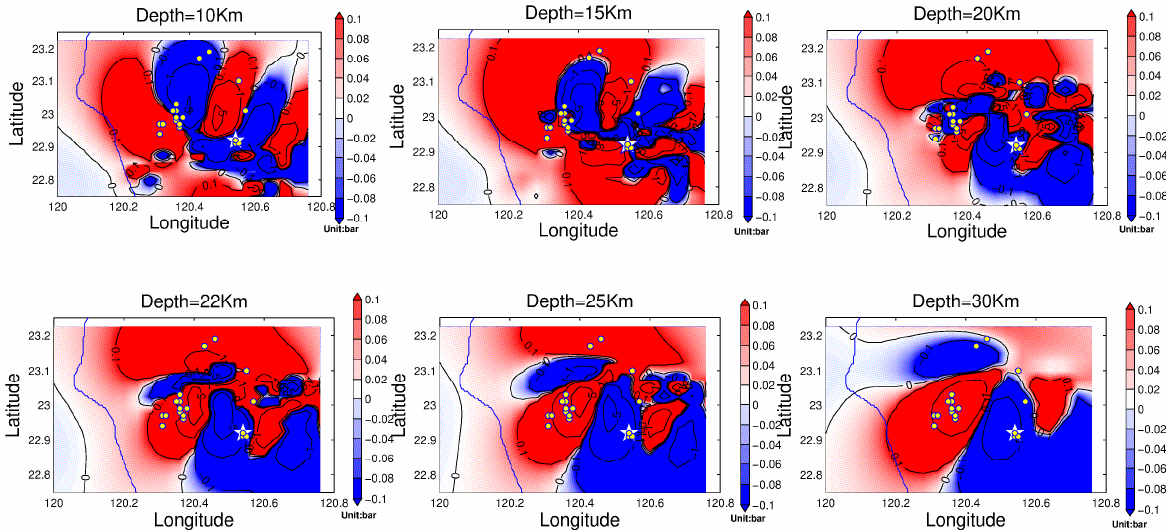
Figure 7. Coulomb stress change ( Δ CFS) distributions at different depths (10–30 km). The star represents the hypocenter, and the yellow dots represent aftershocks. Areas with high Δ CFS values were west, east, and north of the hypocenter. Coupled with aftershock activities, the Δ CFS value could be used to explain the mainshock–aftershock relationship and the earthquake’s aftershock triggering mechanism.